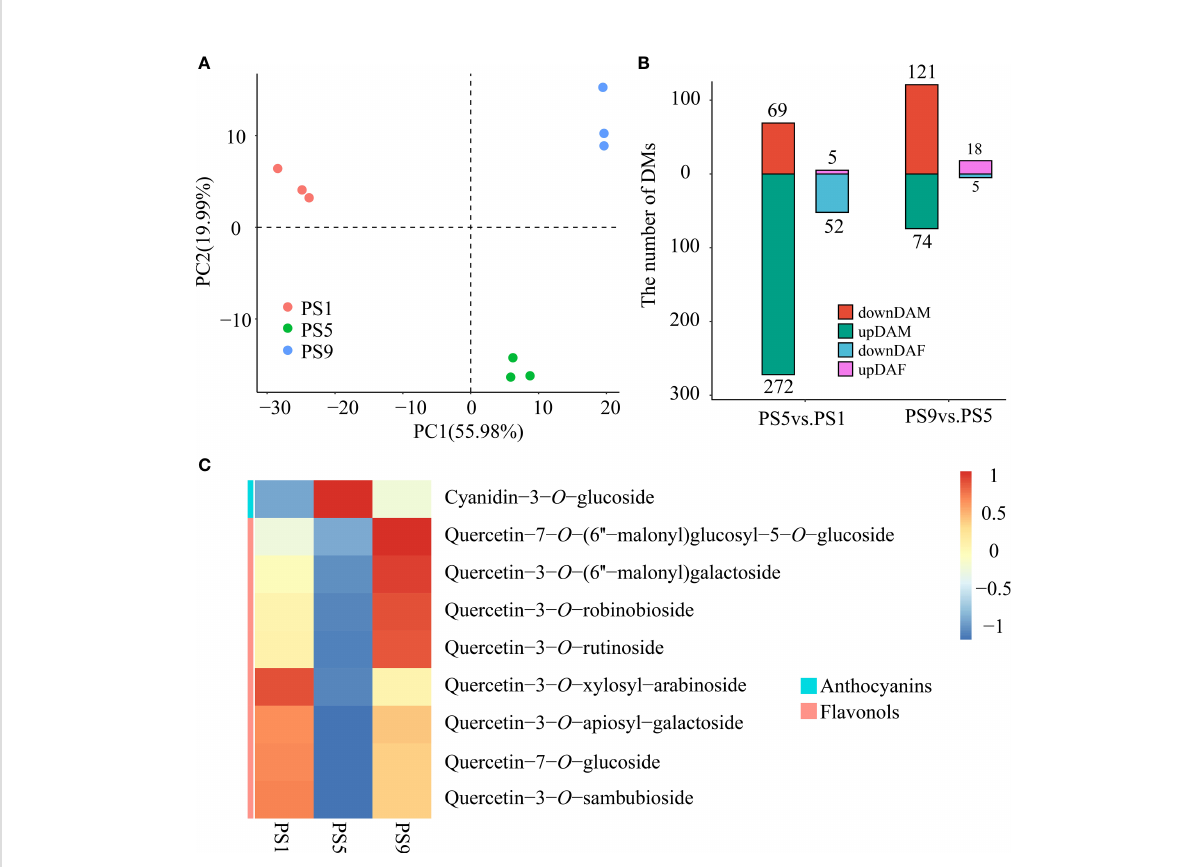
FIGURE 1 Metabolome differences in red apple fruits at three different ripening stages. (A) PCA analysis of red apple fruit metabolome data at PS1, PS5 and PS9; (B) The numbers of differentially accumulated metabolites and fl avonoids in two comparisons. DAM, differentially accumulated metabolites; DAF, differentially accumulated fl avonoids; (C) Differential accumulation was commonly identi fi ed in comparisons of PS5_vs_PS1 and PS9_vs_PS5 of anthocyanins and fl